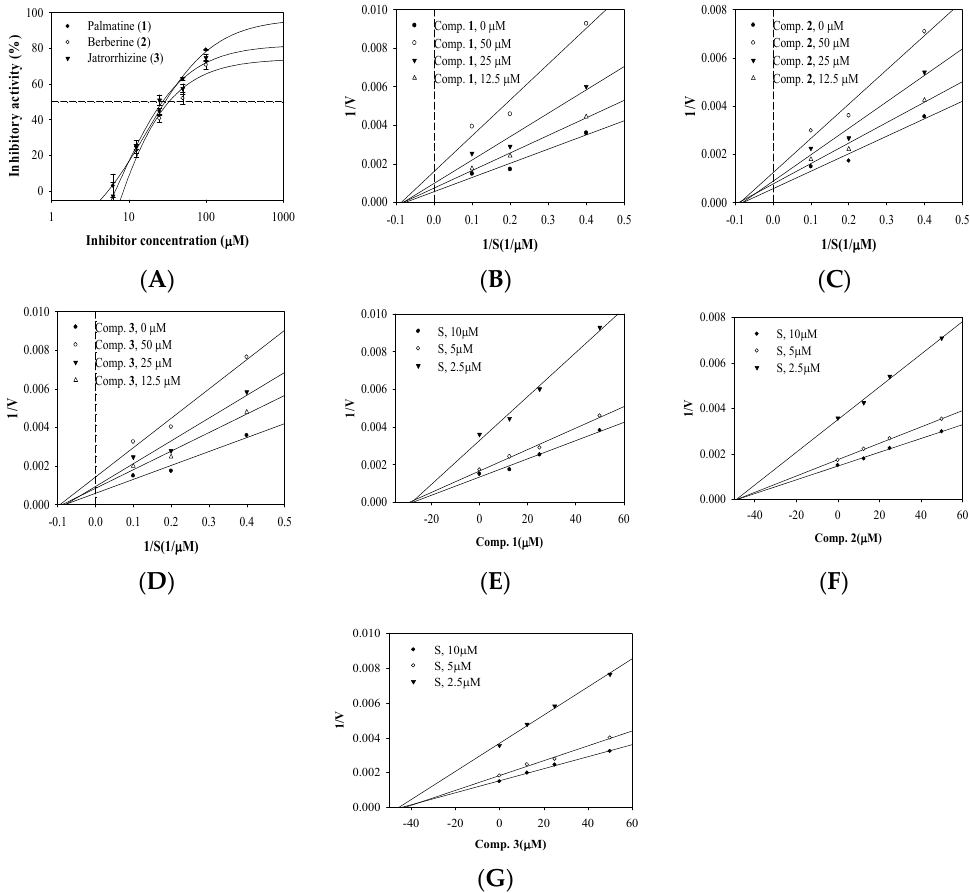
Table 1. sEH inhibitory effect of quaternary isoquinoline alkaloids 1 – 3